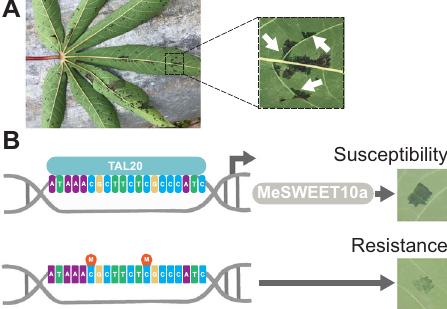
Fig. 1 | Overview of strategy to improve disease resistance using epigenetic modi fi cation. A Left: Example of CBB-infected cassava in a fi eld (Uganda, 2019). Right:selectedregionfromleafontheleft.Water-soakedregionsareindicatedwith white arrows. B Graphical representation of epigenetic CBB disease resistance strategy. Top: In WT plants, TAL20 from Xam binds a speci fi c sequence (EBE)